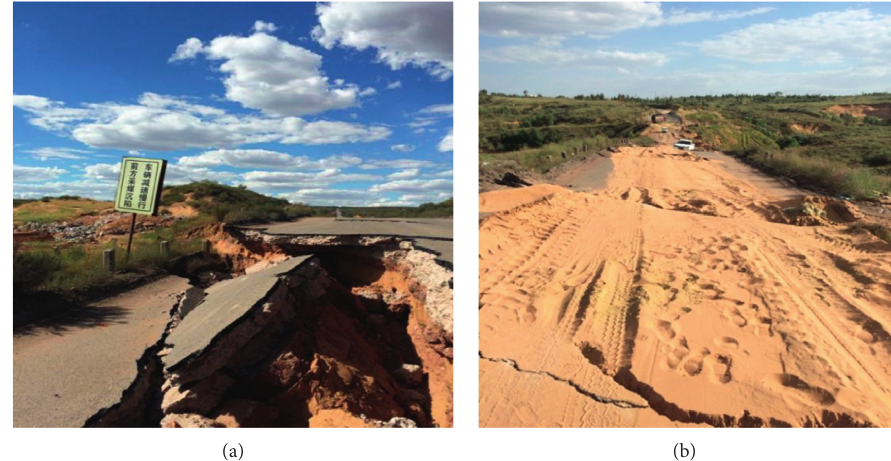
Figure 3: Surface cracks caused by underground mining. (a) 50 meters away from the open-off cut; (b) 120 meters away from the open-off